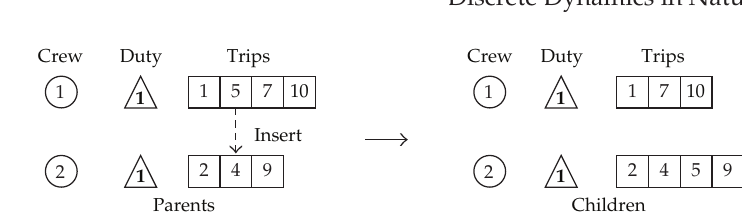
Figure 5: Trips insert